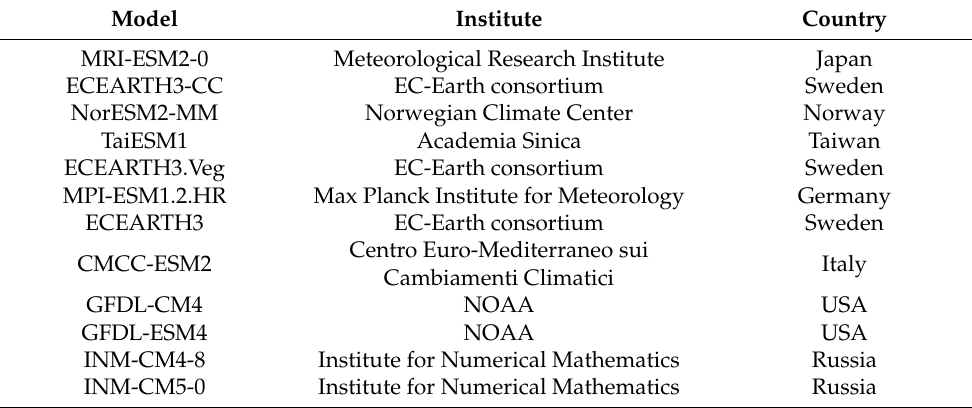
Table 2. List of climate models used in the selection process.